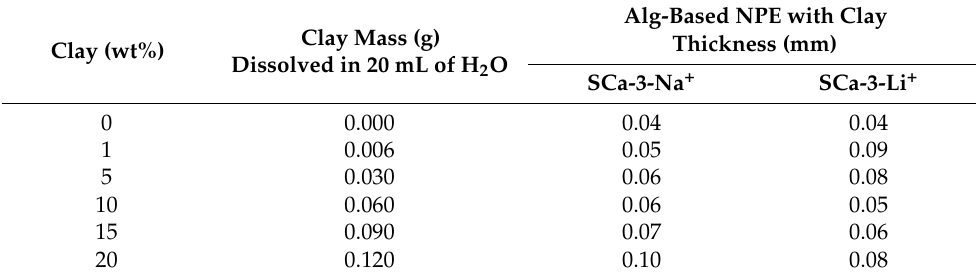
Table 1. Alg-based NPEs clay content and membranes’ thicknesses.